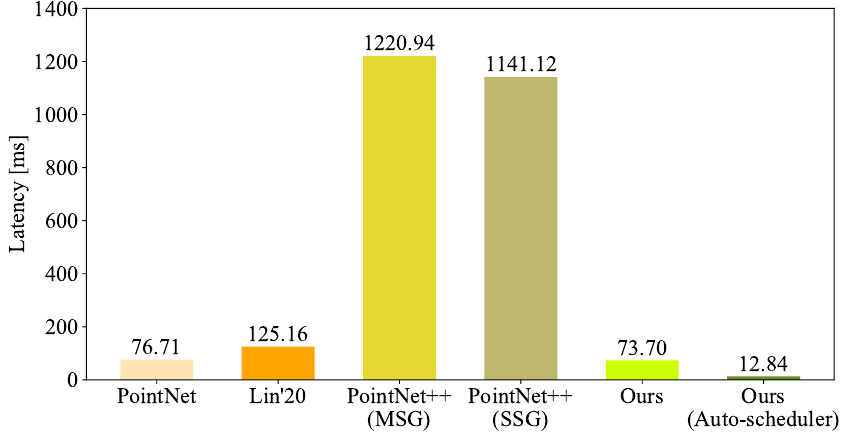
Figure 13. Comparison of the latency on the Nano